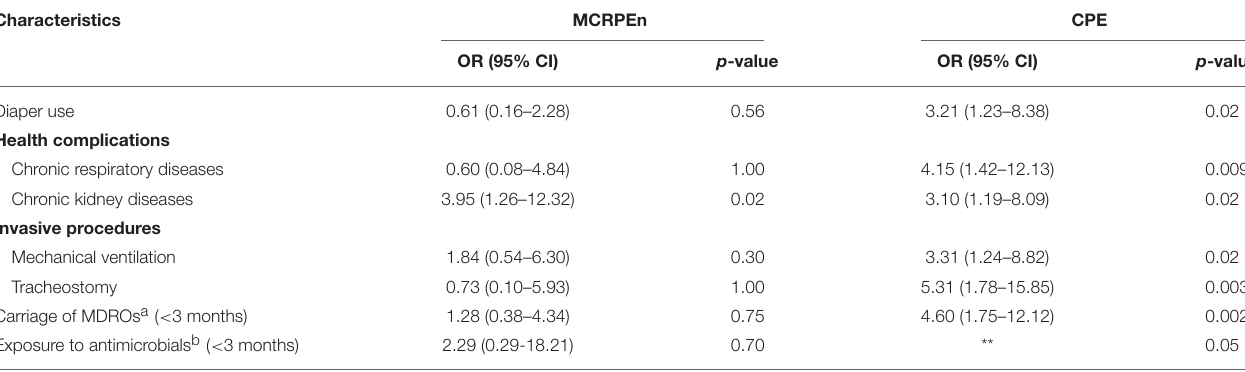
TABLE 4 | Risk factors associated with MCRPEn and CPE